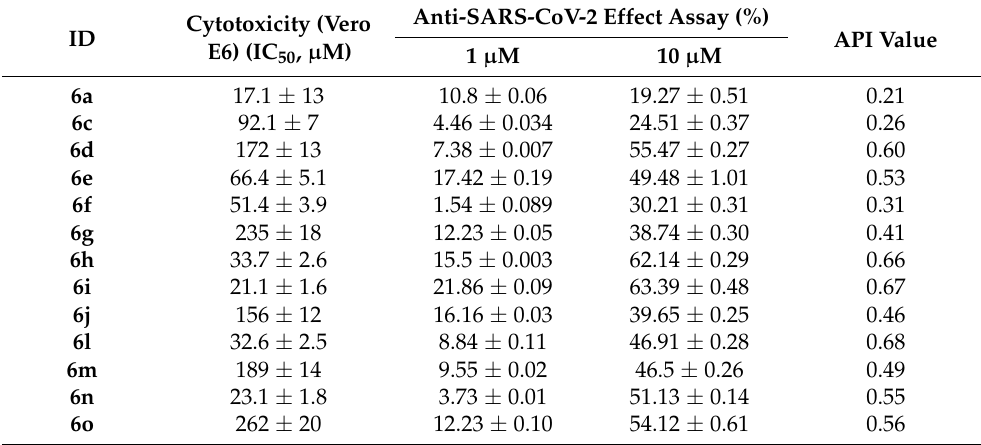
Table 2. Antiviral activity of novel non-covalent SARS-CoV-2 Main protease inhibitors by propagation in Vero E6